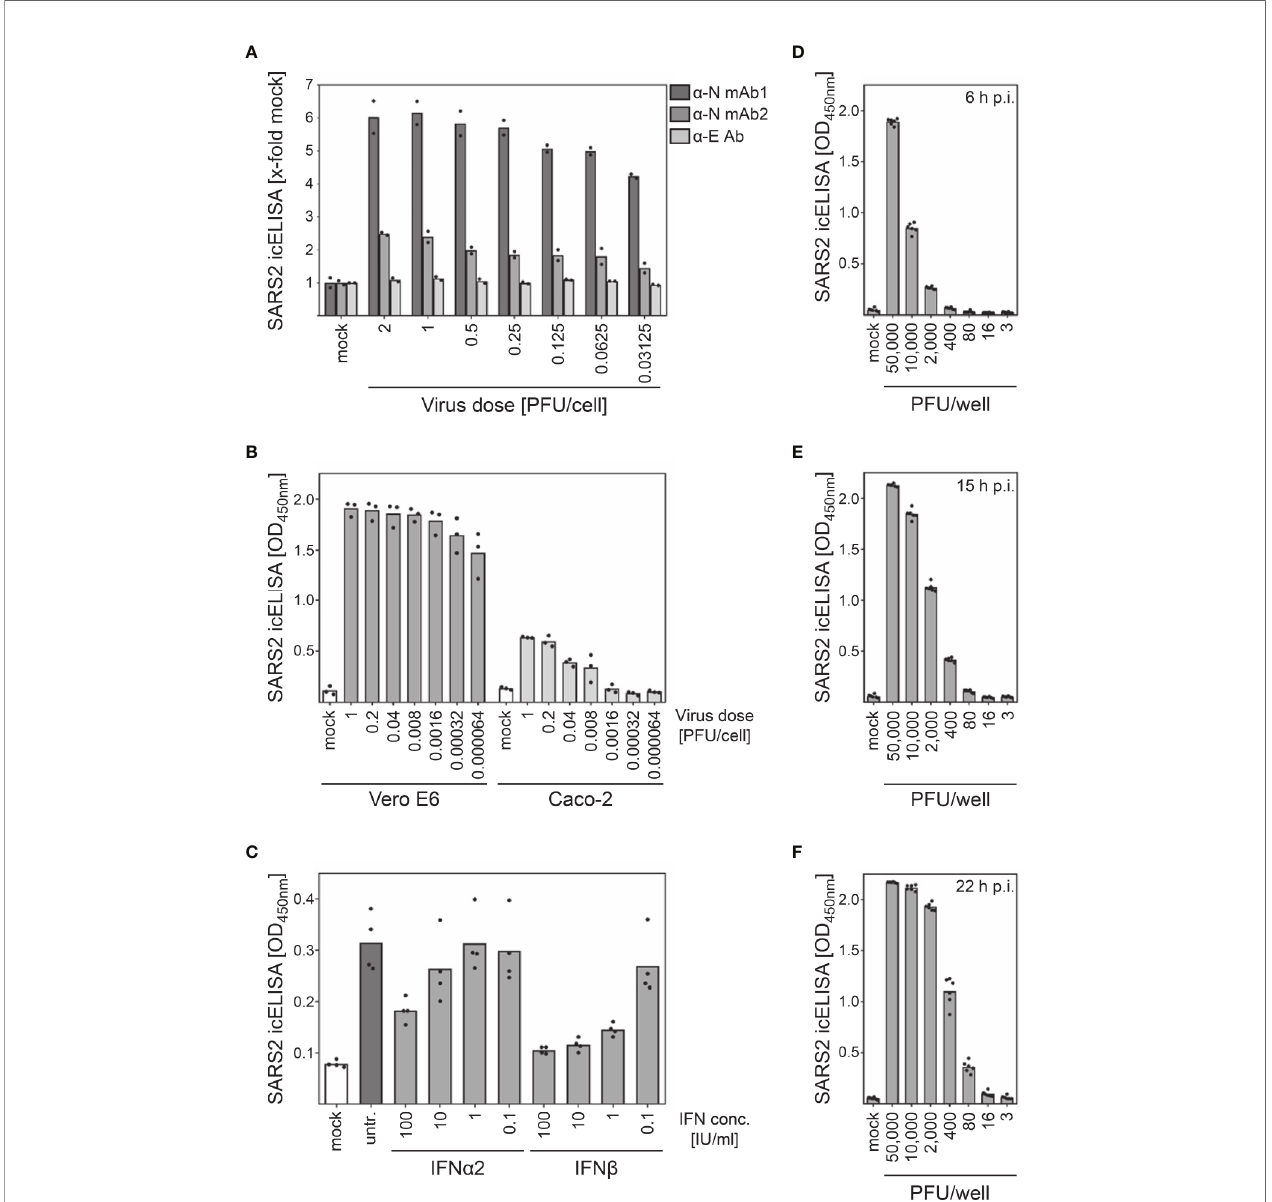
FIGURE 1 | The icELISA test allows quanti fi cation of SARS-CoV-2 replication and its inhibition by antiviral compounds. (A) Caco-2 cells were infected with indicated doses of SARS-CoV-2. At 3 d p.i., cells were fi xed and detected by icELISA using E- and N-speci fi c primary antibodies. For all further icELISAs, a -N mAb1 was used. (B) Vero E6 and Caco-2 cells were infected with indicated doses of SARS-CoV-2. At 3 d p.i., cells were analyzed by icELISA. (C) Caco-2 cells were treated with indicated concentrations of IFN a 2 or IFN b . At 3 h post treatment, cells were infected with SARS-CoV-2 (MOI 0.1). Viral replication was evaluated at 3 d p.i. by icELISA. (D – F) Vero E6 cells were infected with indicated doses of SARS-CoV-2. At 6, 15, and 22 h p.i. (D, E, and F, respectively), and cells were analyzed by icELISA. Bars depict the mean values. Dots show the values of the individual